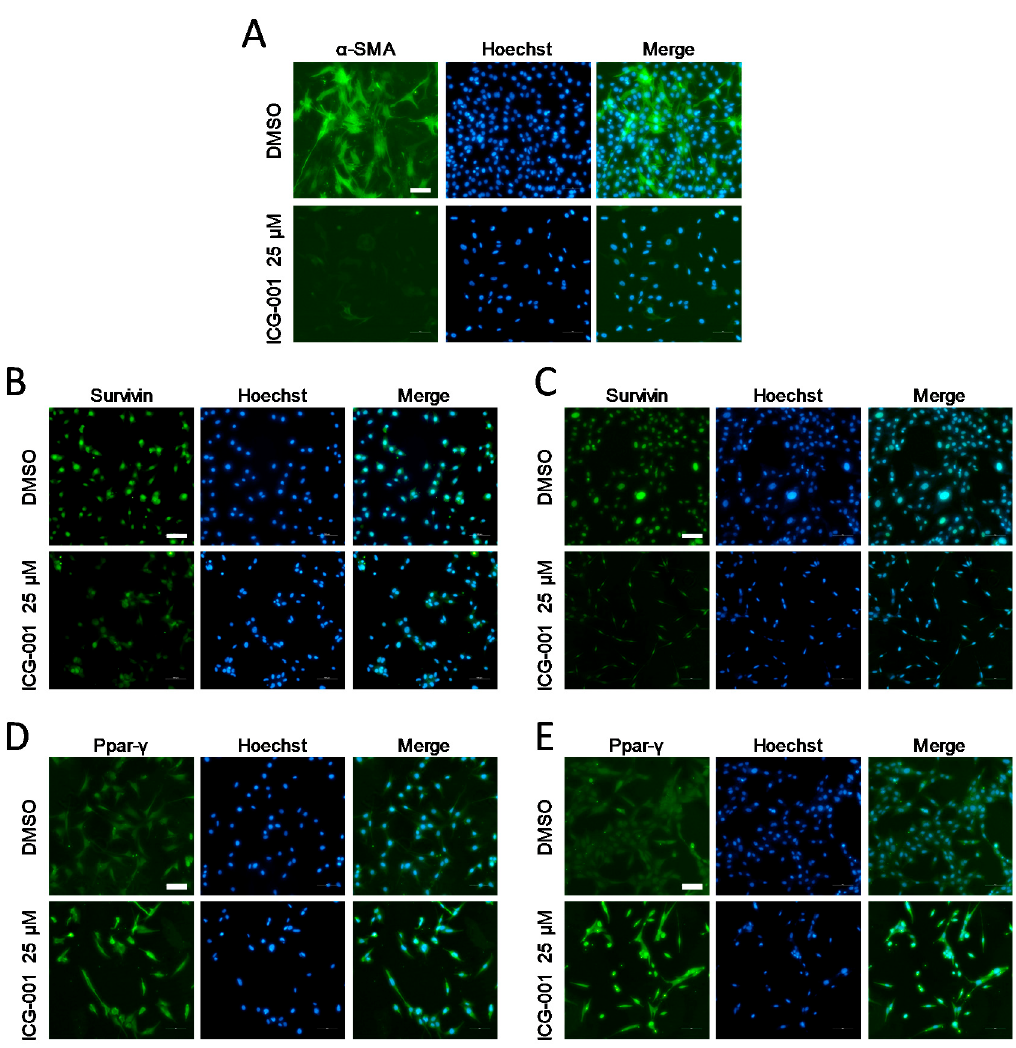
Figure 3. CBP/ β -catenin antagonism suppresses protein expression of activation markers of pancreatic stellate cells as assessed by immunofluorescence. Effect of CBP/ β -catenin antagonist ICG-001 versus control (DMSO) treatment for 72 h of immortalized mouse pancreatic stellate cells (imPSC) on protein expression of activation markers, Acta2 ( α -SMA) ( A ); and Survivin ( B ); and Ppar- γ which is associated with quiescence ( D ); Effect of ICG-001 treatment for 72 h of immortalized human pancreatic stellate cells (ihPSC) on protein expression of activation markers, SURVIVIN ( C ); and PPAR- γ ( E ); Scale bar: 100 μ m. Hoechst: Hoechst 33342.